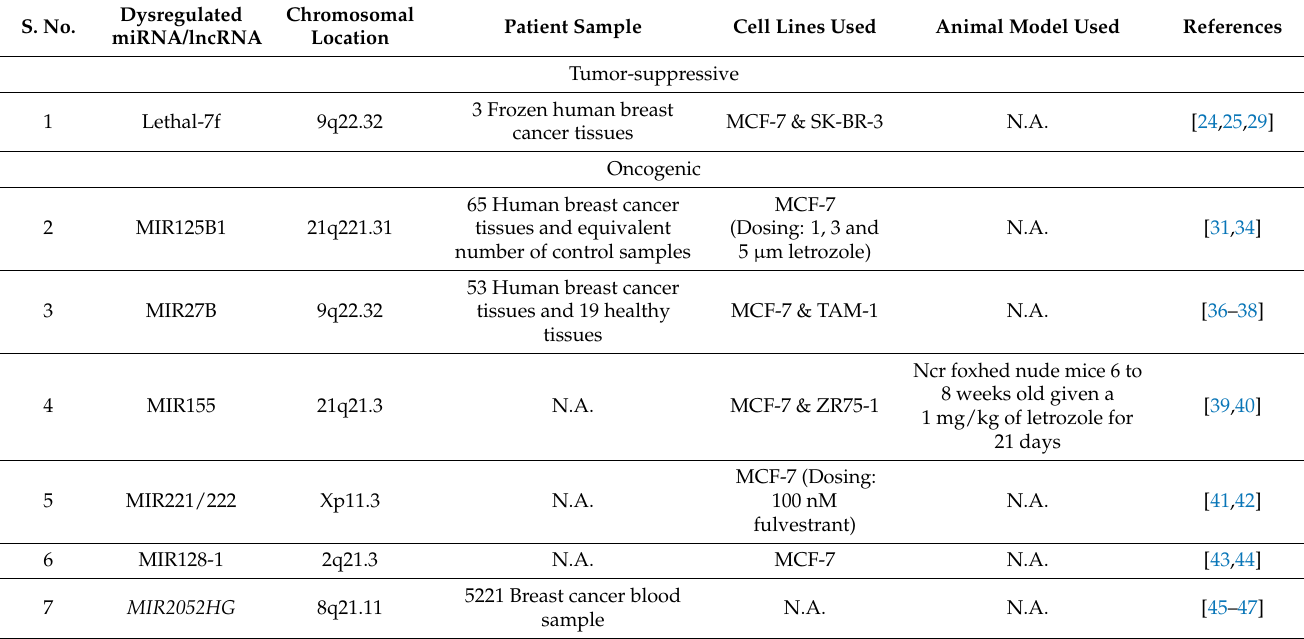
Table 1. Dysregulated ncRNAs associated with aromatase dysregulation in breast cancer. S.